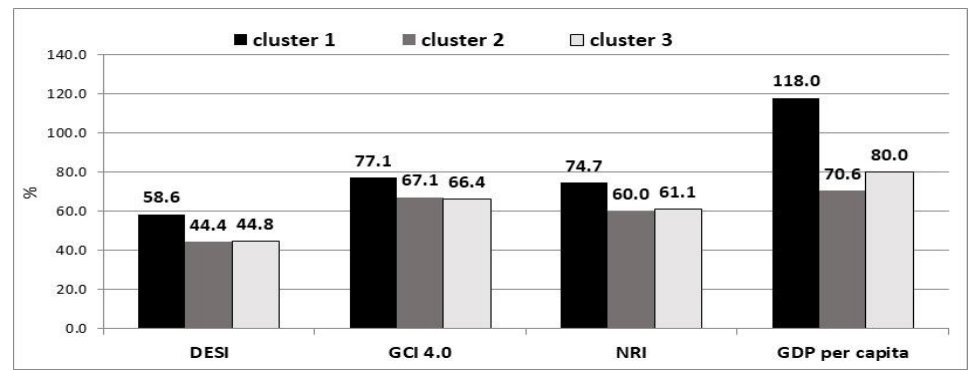
Figure 6. Digitalization, economic development and competitiveness (mean values per cluster).